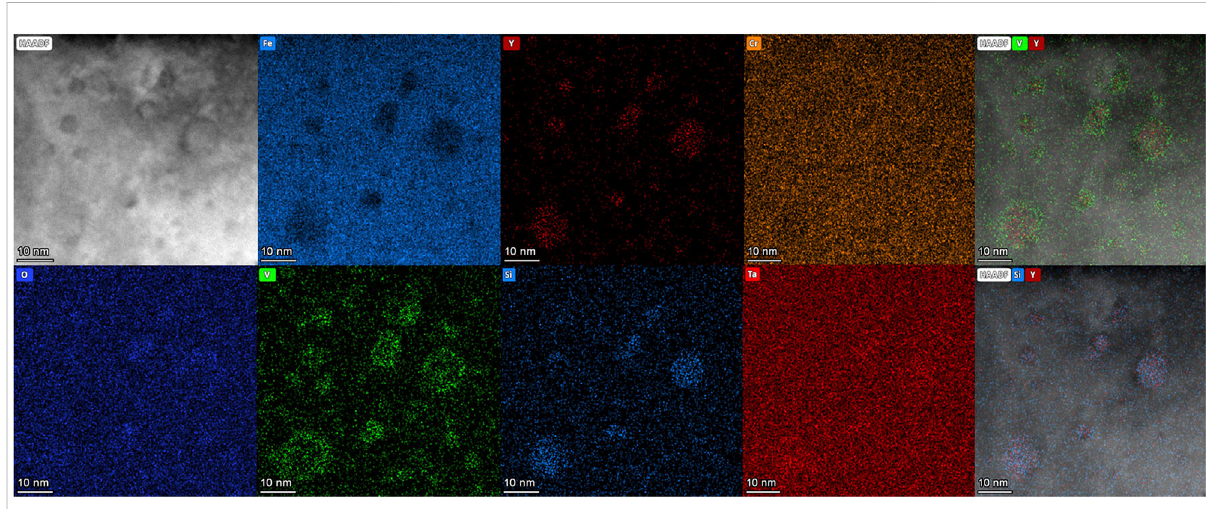
FIGURE 5 HADDF image and EDS elemental mappings showing the chemical compositions of oxide nano-precipitates and shell-core